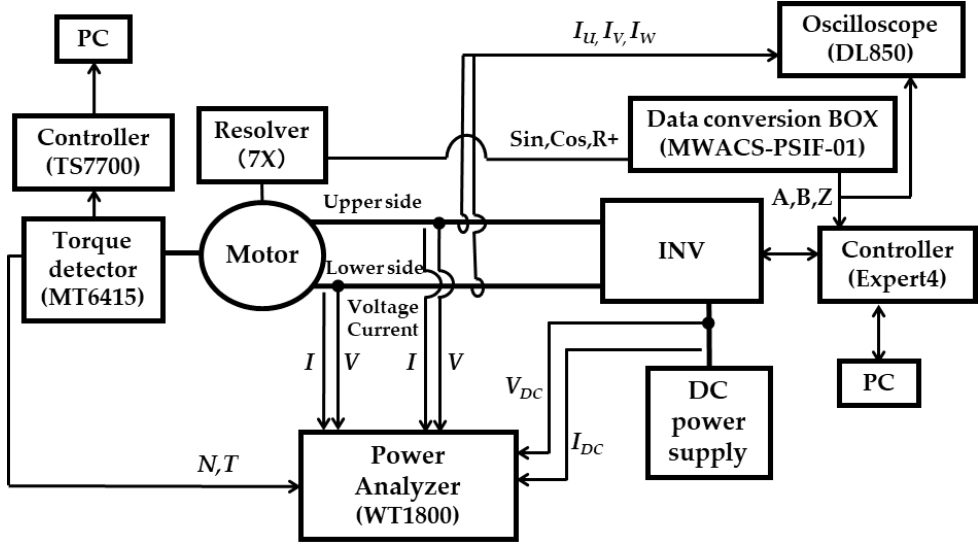
Figure 24. Measurement system configuration.